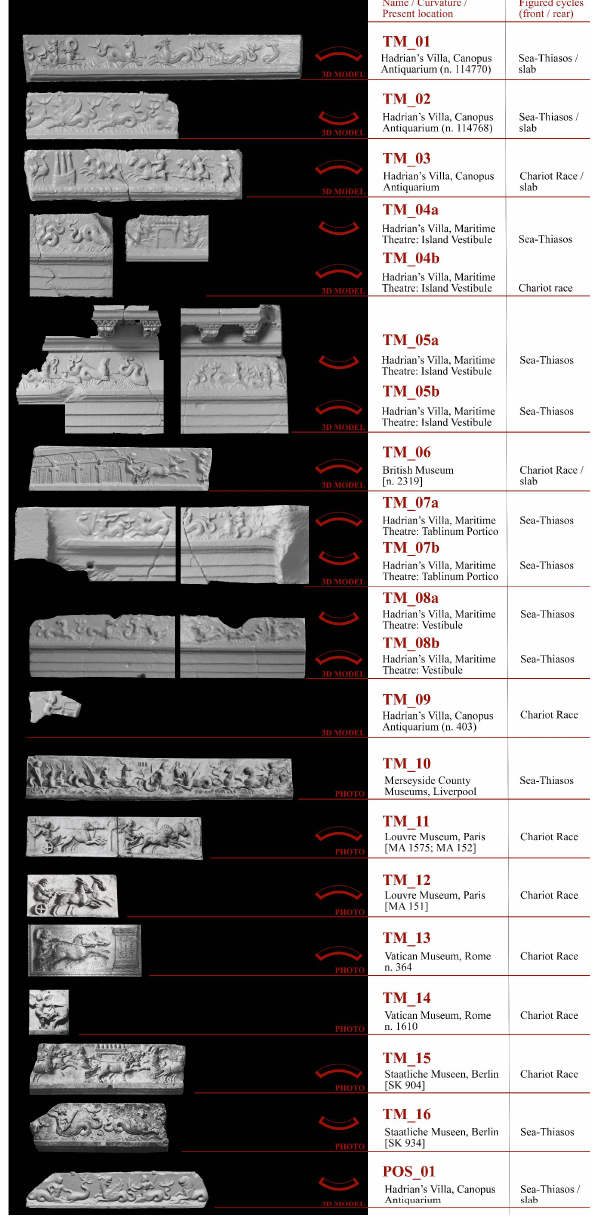
Figure 9. Catalogue of the existing friezes and their actual location, curvature and dimensional information In other cases, it was useful to consider the interaxle spacing between columns to exclude or confirm the possible arrangement of decorated elements. It is the case of the frieze TM_01 that presents a radius compatible with two circumferences (N-B-6 and S-B-4), but the second one can be excluded: in fact the length of the frieze is bigger than the limited interaxle spacing of the first intercolumnio starting from the right. The TM_01 frieze was placed upon the second intercolumniation in the right side of the Vestibule, since the first one has a different curvature: this point is the connection between the Vestibule and the entablature of the side facing the